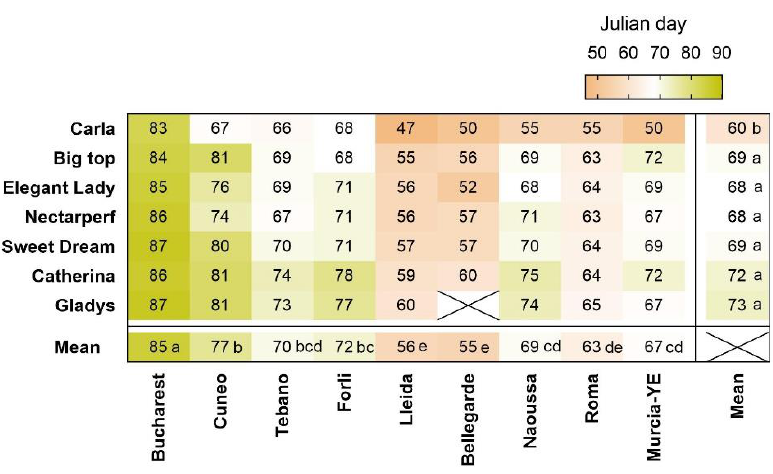
Figure 5. Heat-map showing Julian days of beginning of bloom in 7 cultivars located in 9 sites. Mean values for 2021 and 2022 are shown. X = no data. YE = Yéchar. Means with different letters indicate significant differences among sites and cultivars, using the Tukey multiple range test.